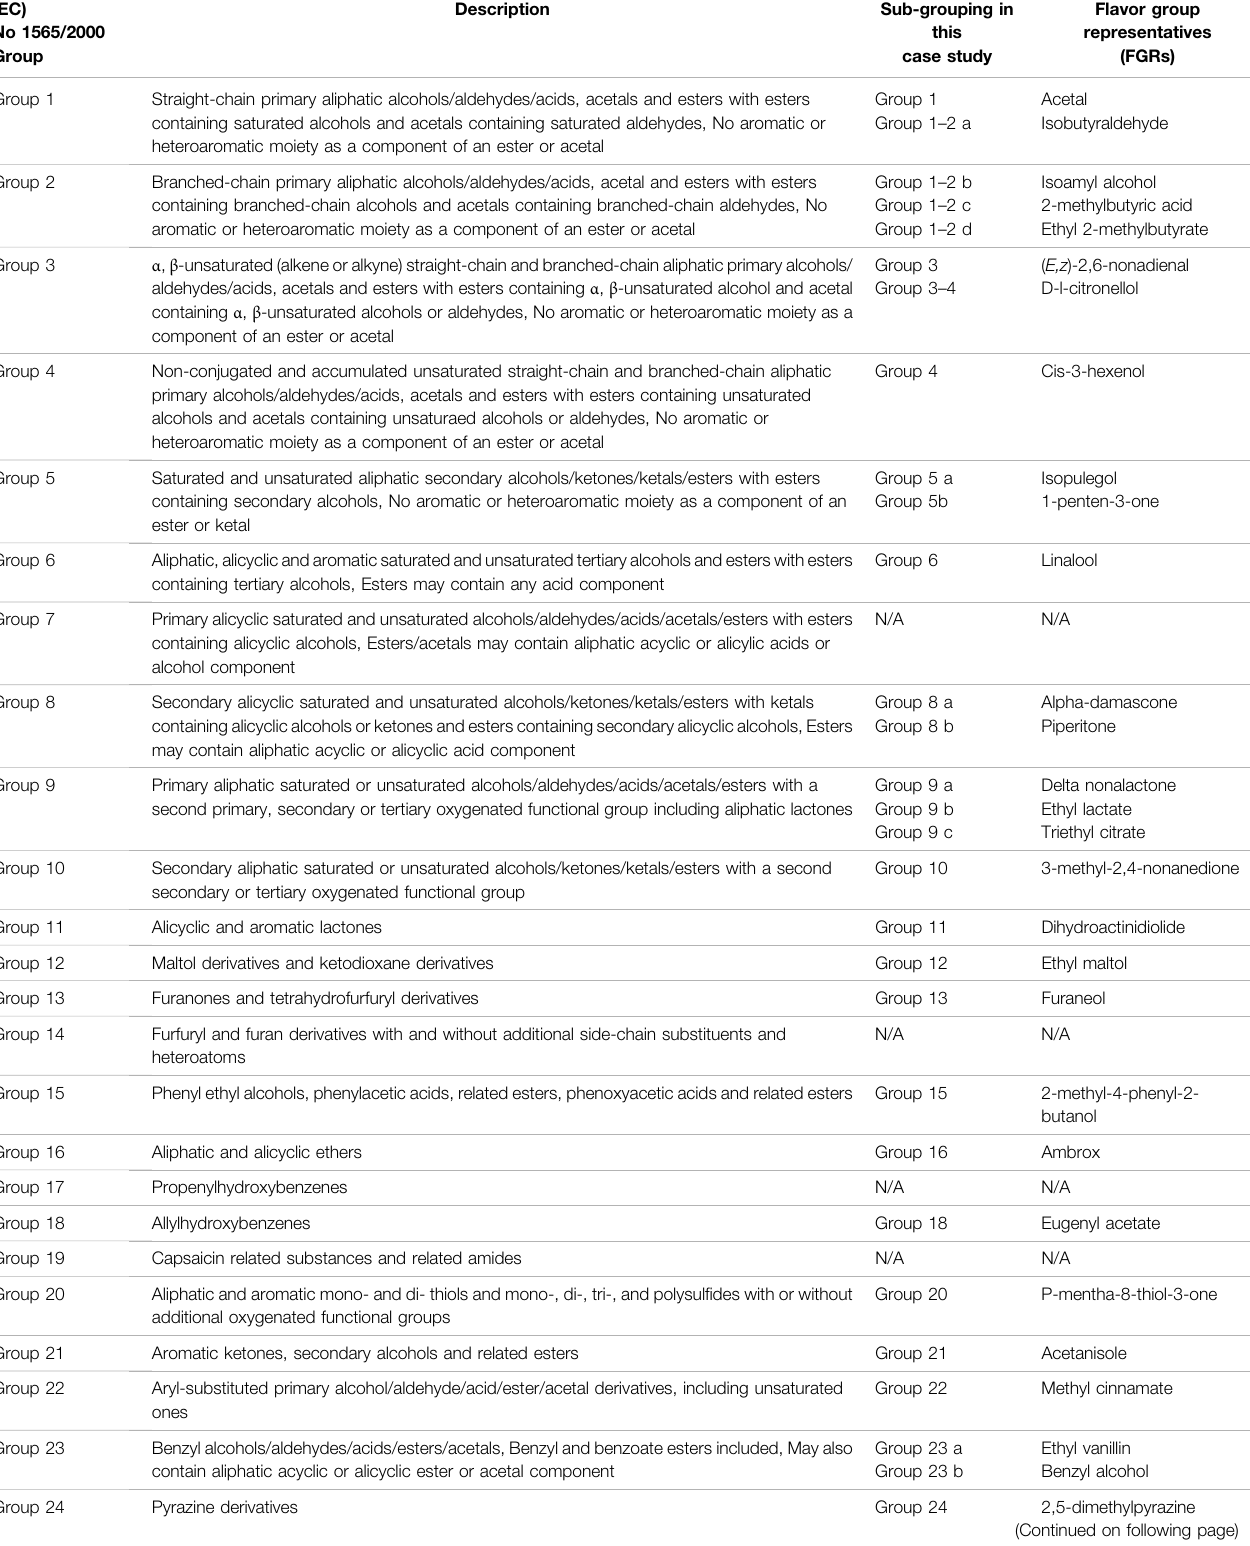
TABLE 3 | Chemical groups for fl avor ingredients de fi ned in the commission regulation (EC) No1565/2000 and further subclustering and selected FGRs for this case study. (EC) No 1565/2000 Group Group